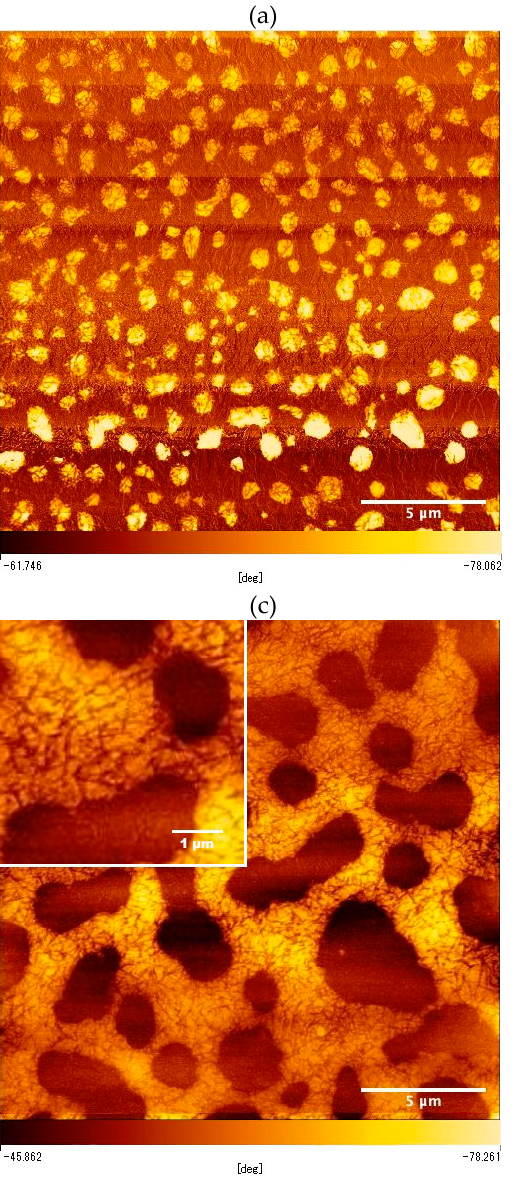
Figure 1. The SFM phase images of PB/PEG blend films with P3HT nanofiber, with φ PB values of ( a ) 0.22, ( b ) 0.40, ( c ) 0.57, and ( d ) 0.72 (20 µm × 20 µm). Top left inset of ( b , c ) shows the magnified image of the phase image. From these images, P3HT nanofibers were confirmed to be selectively localized in the PB phase.